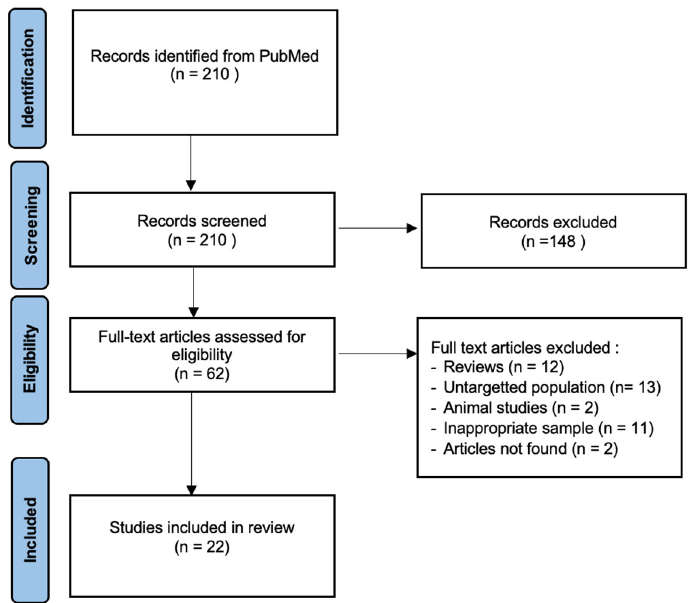
Figure 1. PRISMA flow diagram for identification and selection of studies.